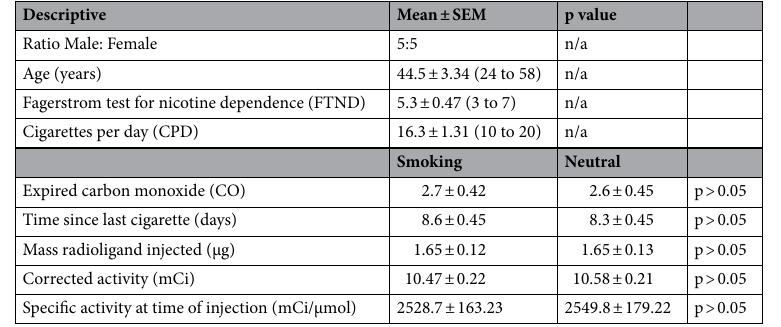
Table 1. Mean ± SEM descriptive characteristics of participants. P values correspond to the results of paired samples t -tests. Range is provided in